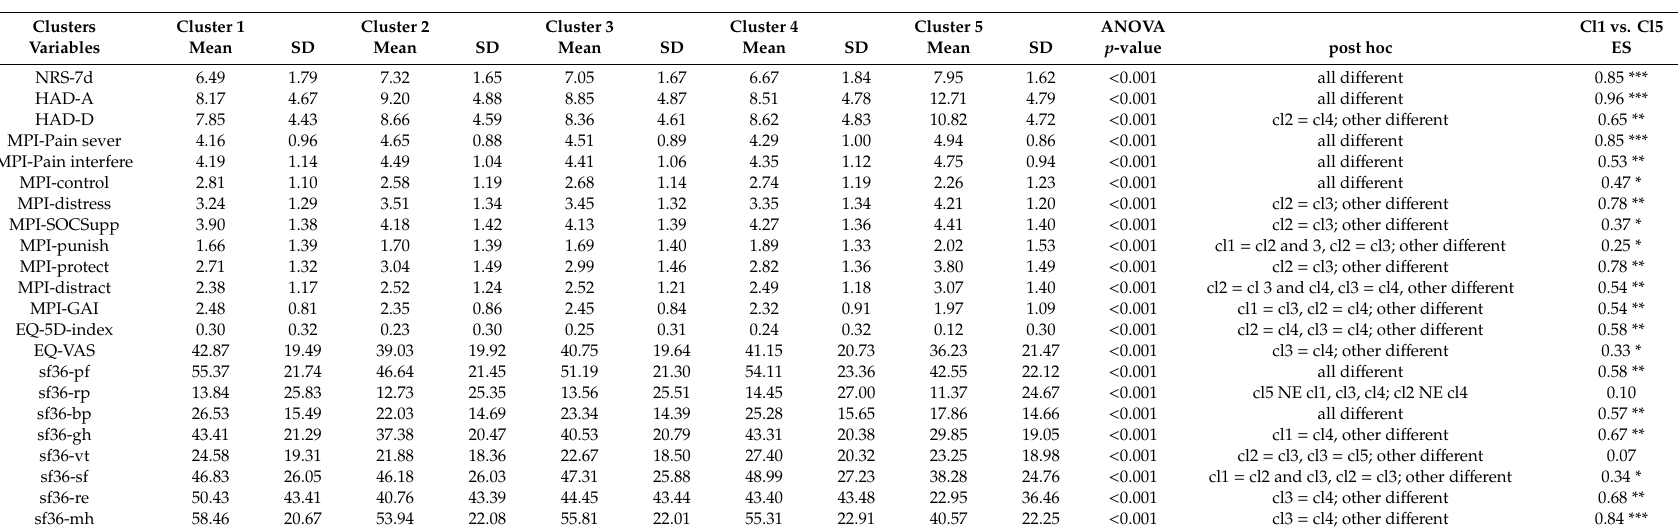
Table 8. Baseline data for the five identified clusters based on sex, education level, and country of birth as input variables. Statistics are furthest to the right—i.e., group comparison (ANOVA) and e ff ect size (ES; Hedges’g).